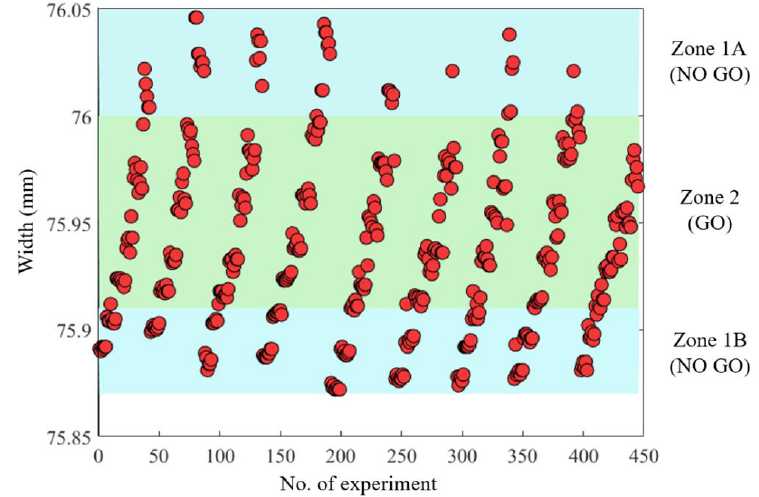
Figure 6. Classification of W1 .